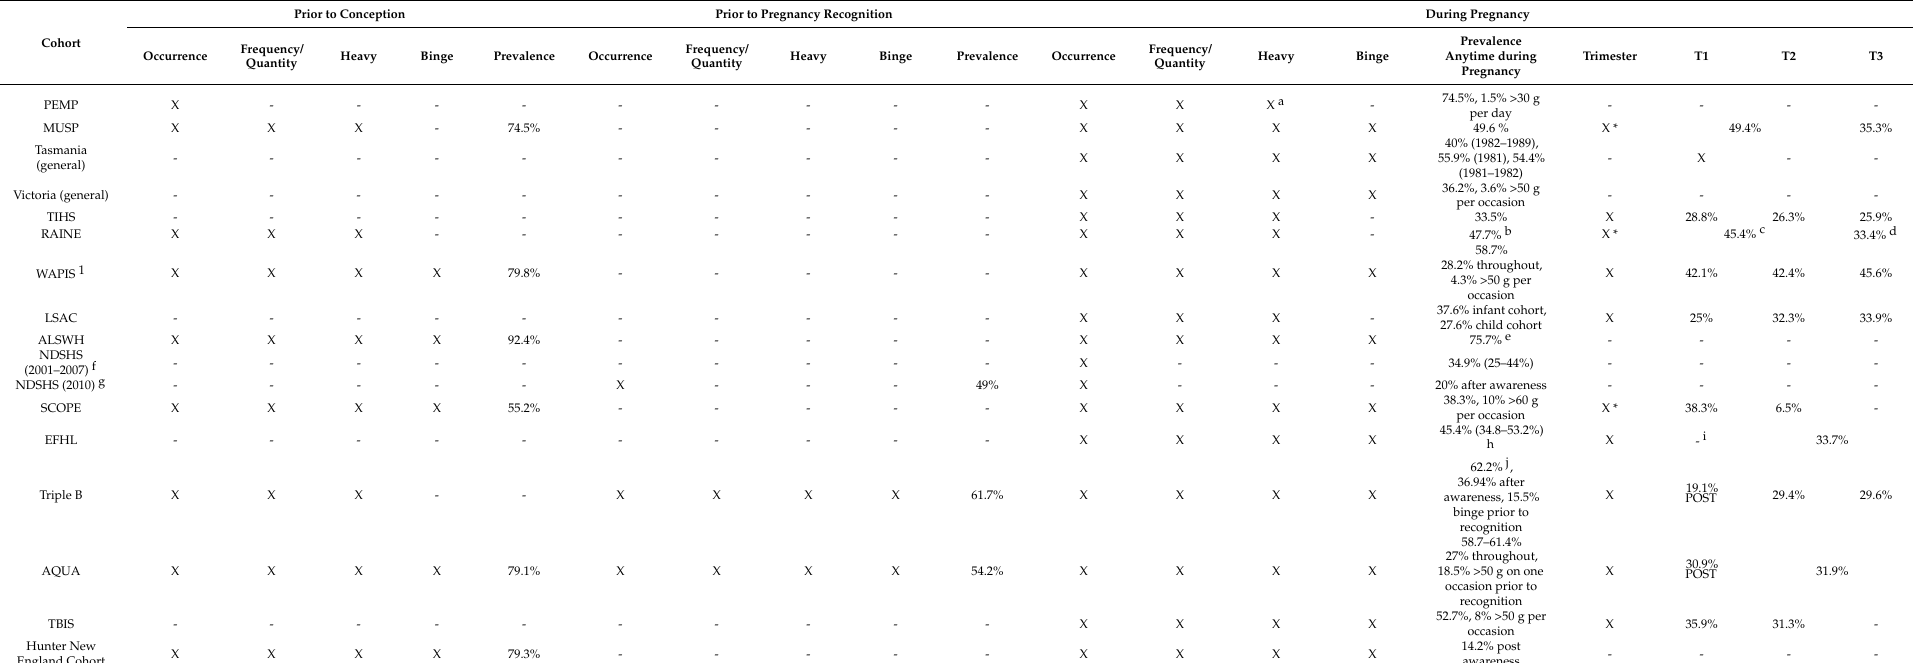
Table 2. Timing and Prevalence of Prenatal Alcohol